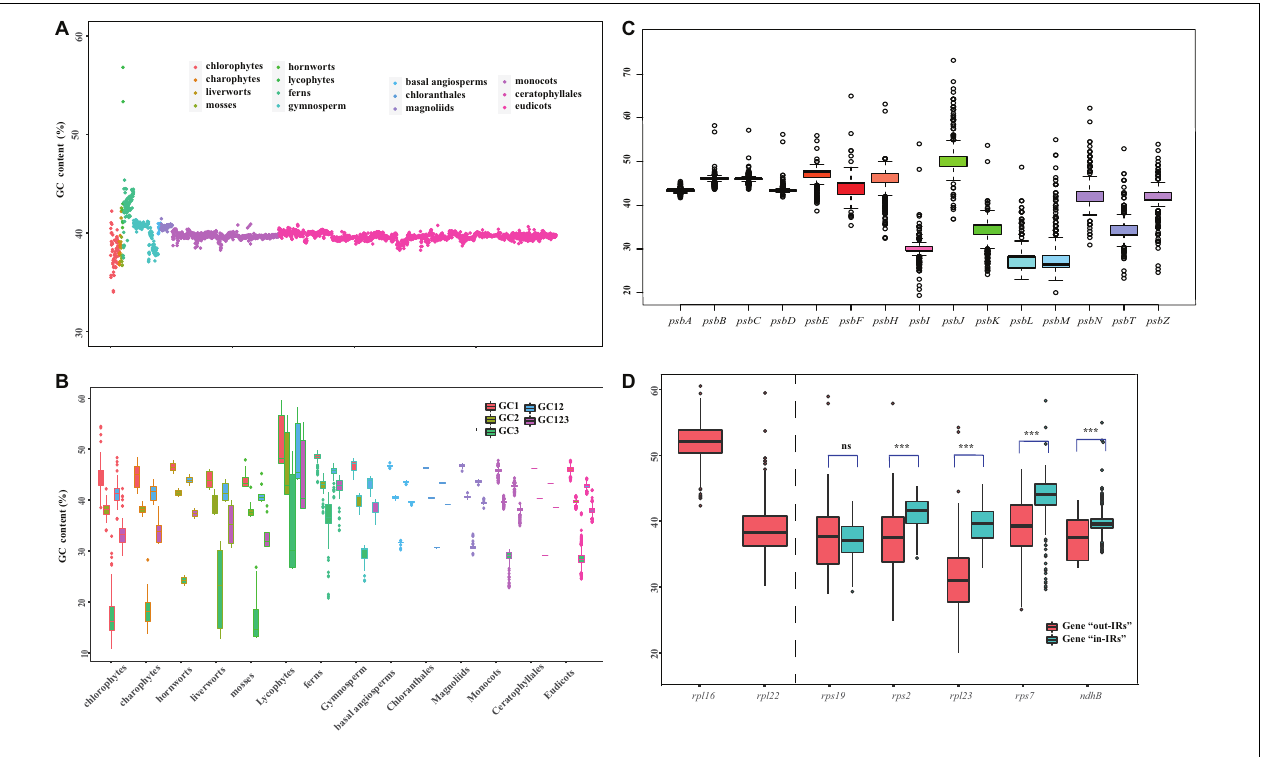
FIGURE 2 | Overview of GC content in Viridiplantae. (A) GC content variation among the 14 major lineages of Viridiplantae. (B) GC content variation based on five sets of 72 protein-coding genes represented by first base (GC1), the second base (GC2), the third base (GC3) of codon, along with GC123 and GC12. (C) GC content variation in psb family genes. (D) GC content variation of five genes located in IR and non-IR region. Boxplots represent minimum, median, and maximum of GC content. Asterisks (*) represent the significant difference from respective genes using Student’s t -test (*** p < 0.001); ns = not